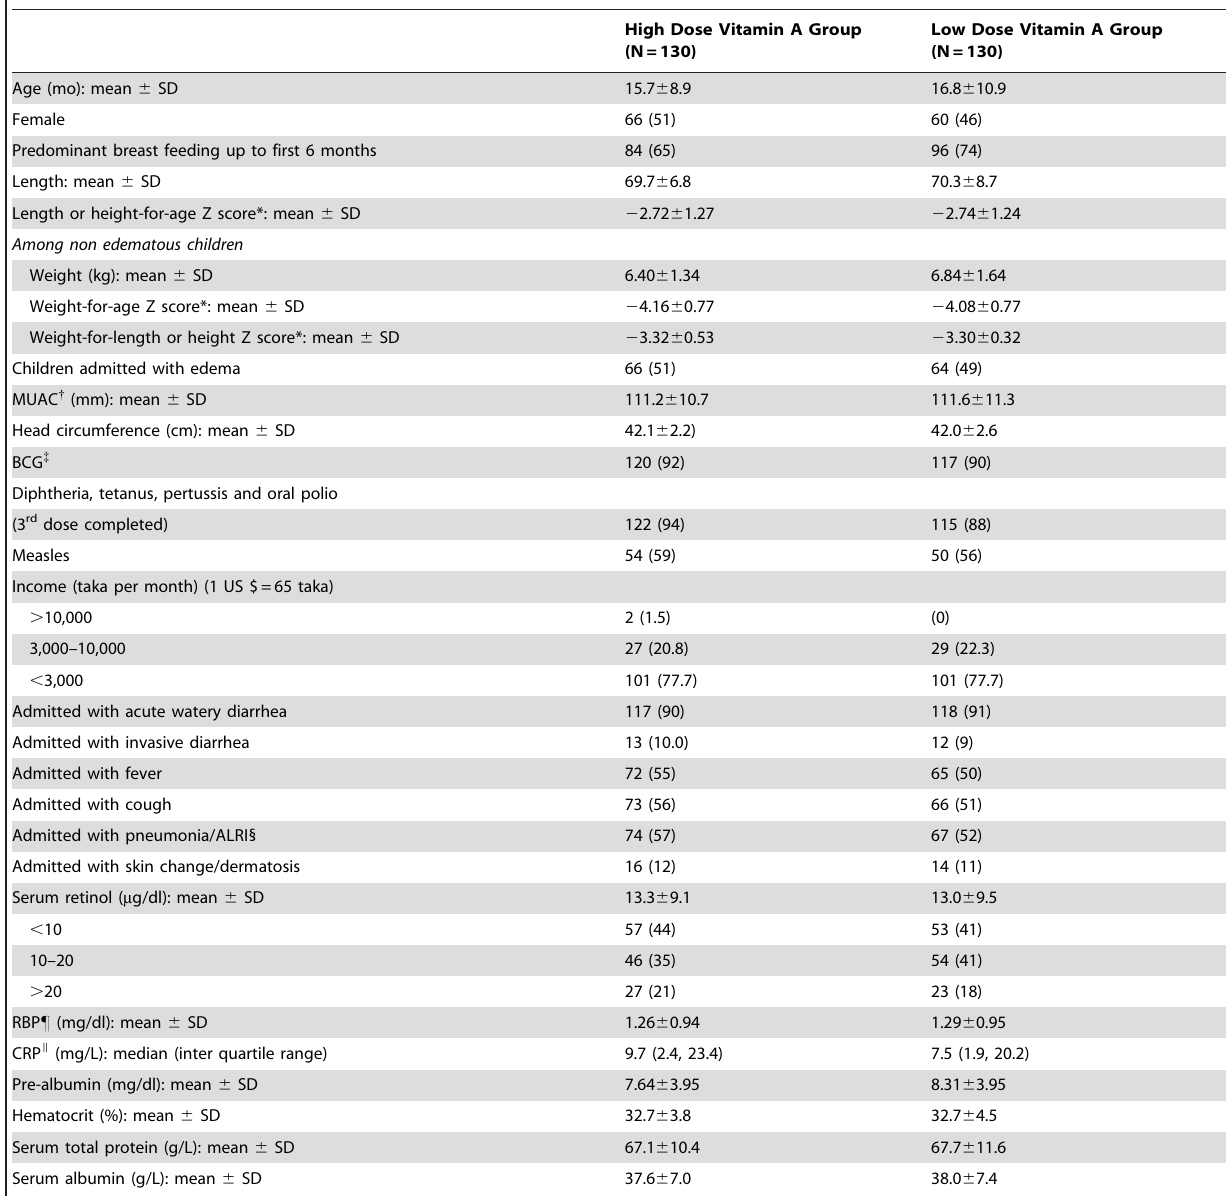
Table 1. Baseline characteristics of children by treatment